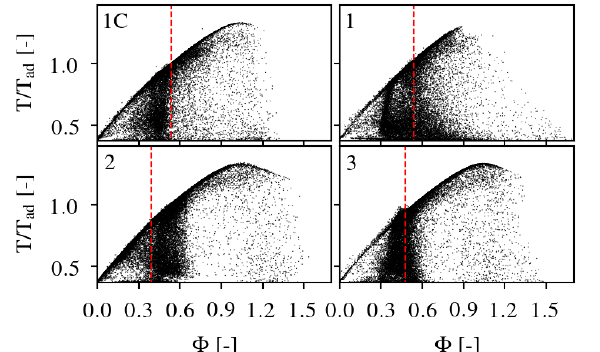
Figure 6. Normalized temperature over equivalence ratio in the combustion chamber for cases 1C, 1, 2 and 3. The vertical dashed line marks the global equivalence